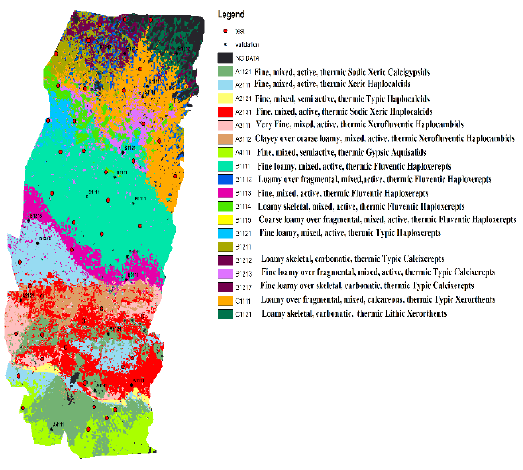
Figure 4. Categorical raster soil map of family